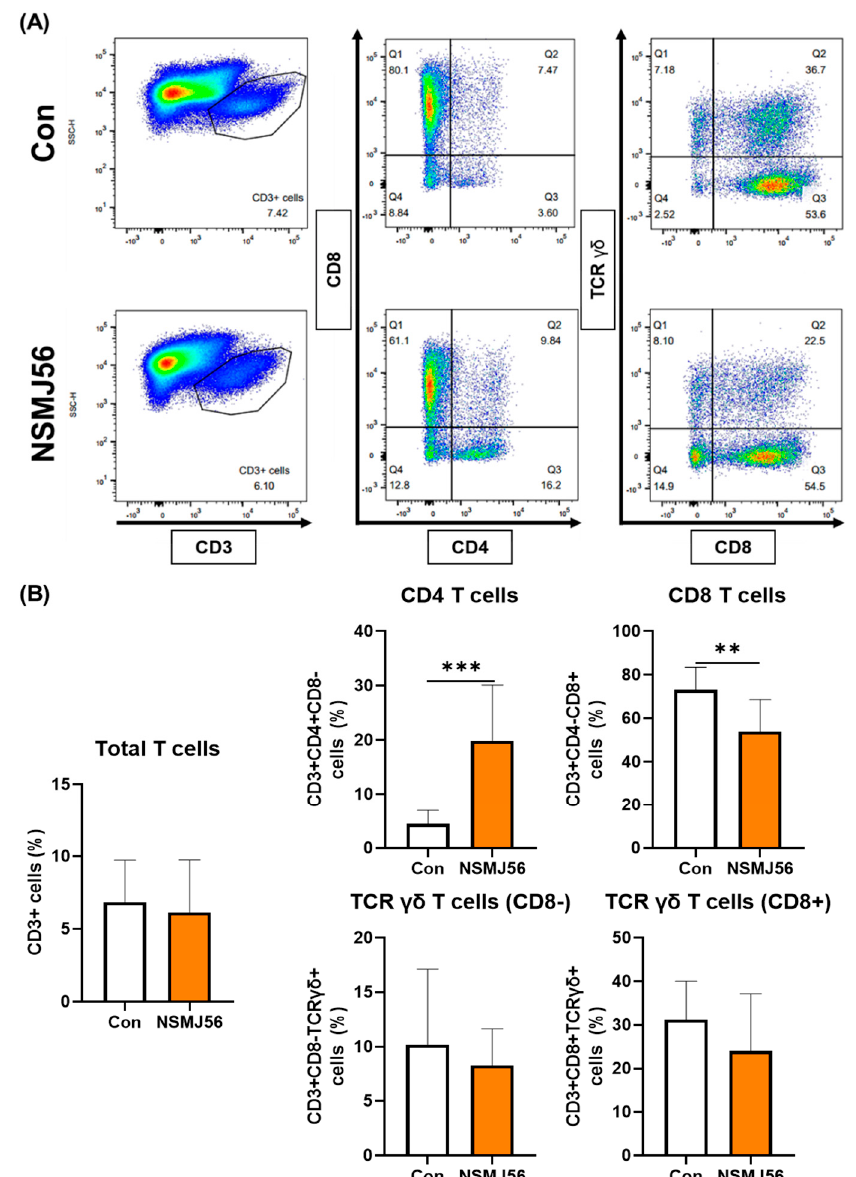
Figure 3. Changes in T cells in the small intestine by NSMJ56 feeding. Broilers were fed a control diet or NSMJ56-containing diet for 10 days. Proportions of total T cells, CD4 T cells, CD8 T cells, and TCR γδ T cells were analyzed by flow cytometry in the 10-day-old broilers. A representative dot plot is shown ( A ) and immune cell distribution is presented ( B ). Data were obtained from the control group ( n = 10) and NSMJ56 group ( n = 6) and presented as means ± SD. Significant differences between the control and NSMJ56 groups were analyzed by a two-tailed unpaired t -test or a Mann–Whitney test. ** p < 0.01 and *** p < 0.001.